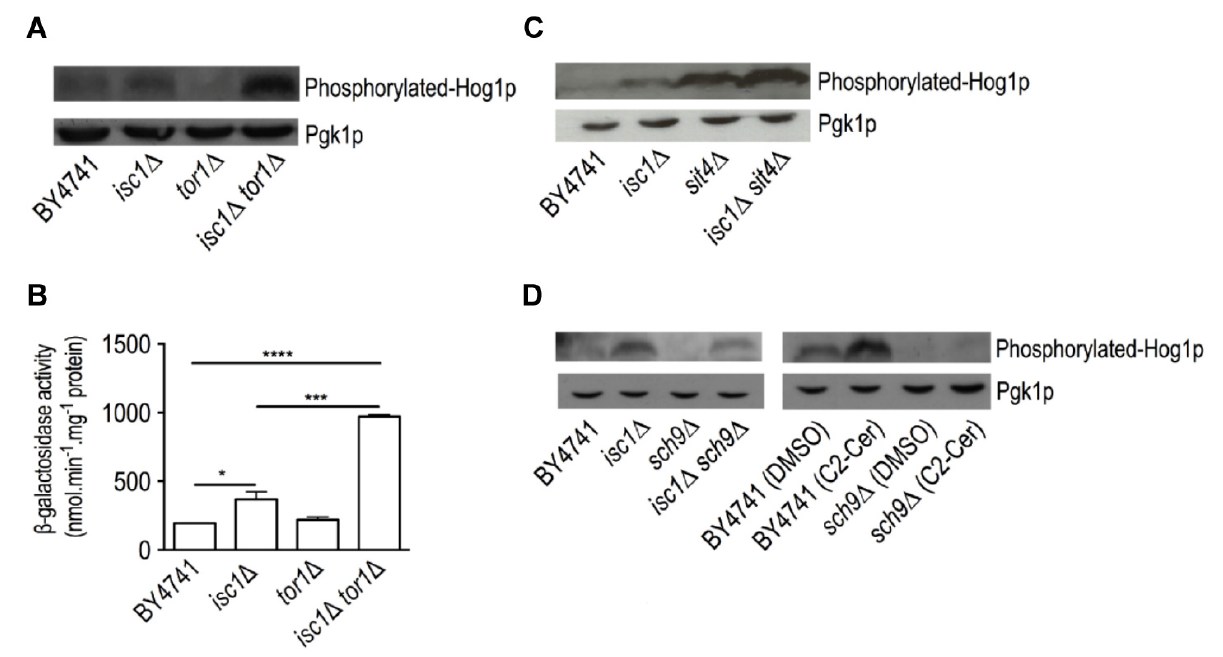
FIGURE 6: The deletion of TOR1 increases Hog1p phosphorylation without affecting its cytosolic localization whereas SCH9 disruption di- minishes Hog1p phosphorylation in isc1 Δ cells. (A) Hog1p activation was monitored in BY4741, isc1 Δ , tor1 Δ and isc1 Δ tor1 Δ cells by im- munoblotting, using anti-phospho-p38 antibody (top panel) that detects the phosphorylated form of Hog1p, or anti-Pgk1p (loading control) as primary antibodies. A representative blot out of three is shown. (B) S. cerevisiae BY4741, isc1 Δ , tor1 Δ and isc1 Δ tor1 Δ cells expressing